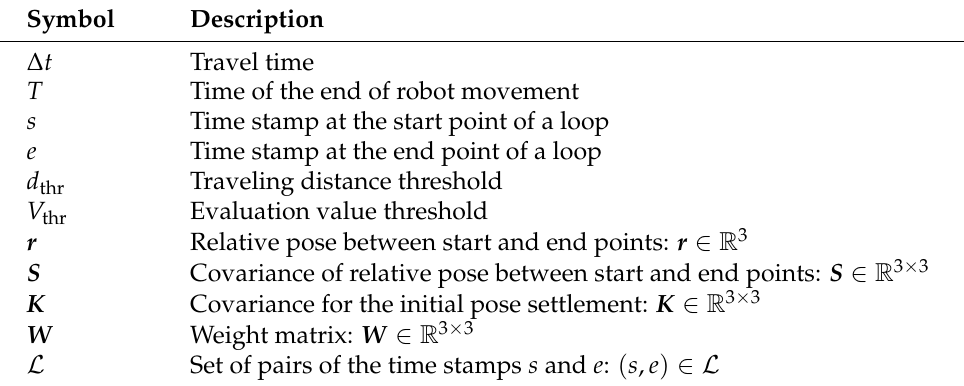
Table 2. Parameter